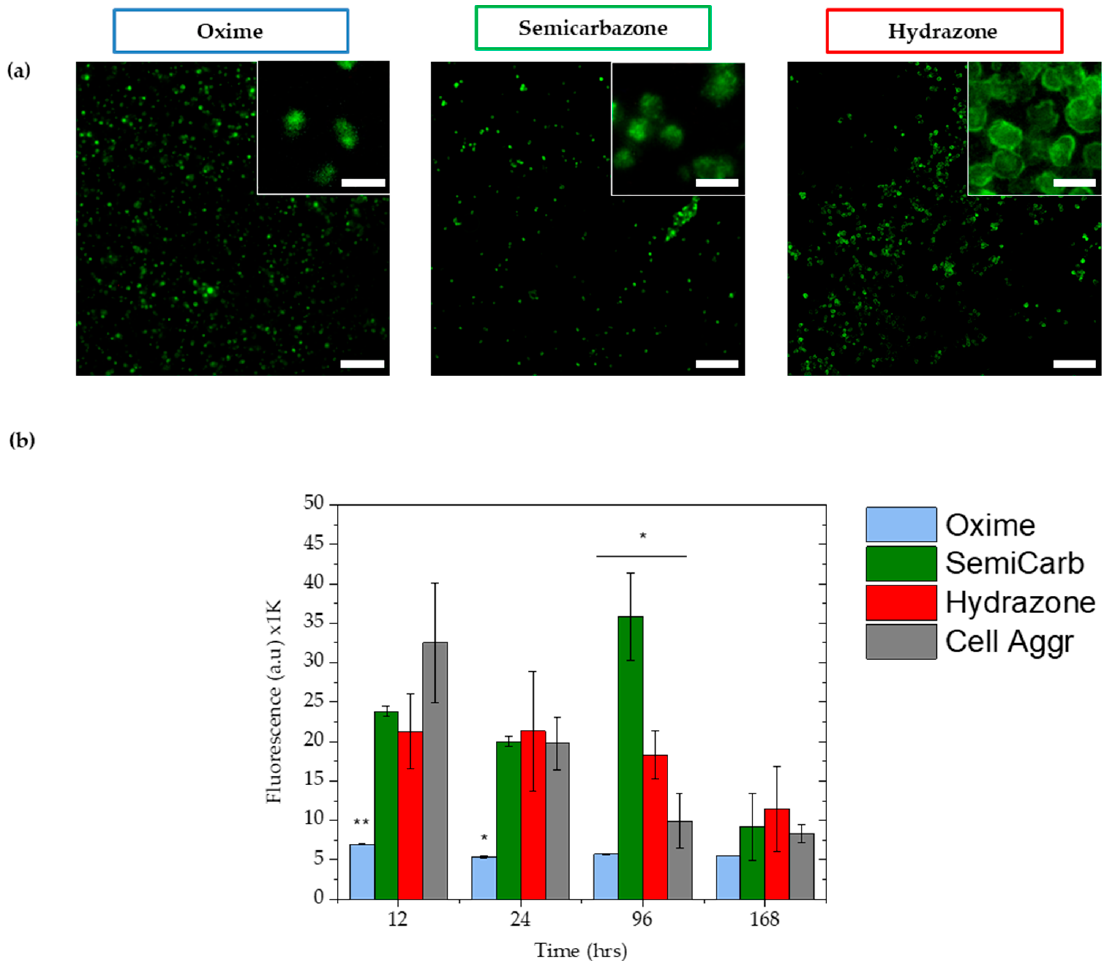
Figure 4. Cell viability: ( a ) Image showing live cells (in green) after seven days of encapsulation in gels indicating that great majority of cells are live and gels did not cause cytotoxicity, Scale bar: 200 µm and 25 µm for inset images. ( b ) Cell metabolic activity recorded after 12, 24, 96, and 168 hours. The values reported are an average of n = 3, ± standard deviation. * and ** indicates p < 0.05 and p < 0.01 (Student’s t -test, independent sample populations). For “cell aggr” condition, cells were cultured in pellets, a standard for chondrocyte cell culture.